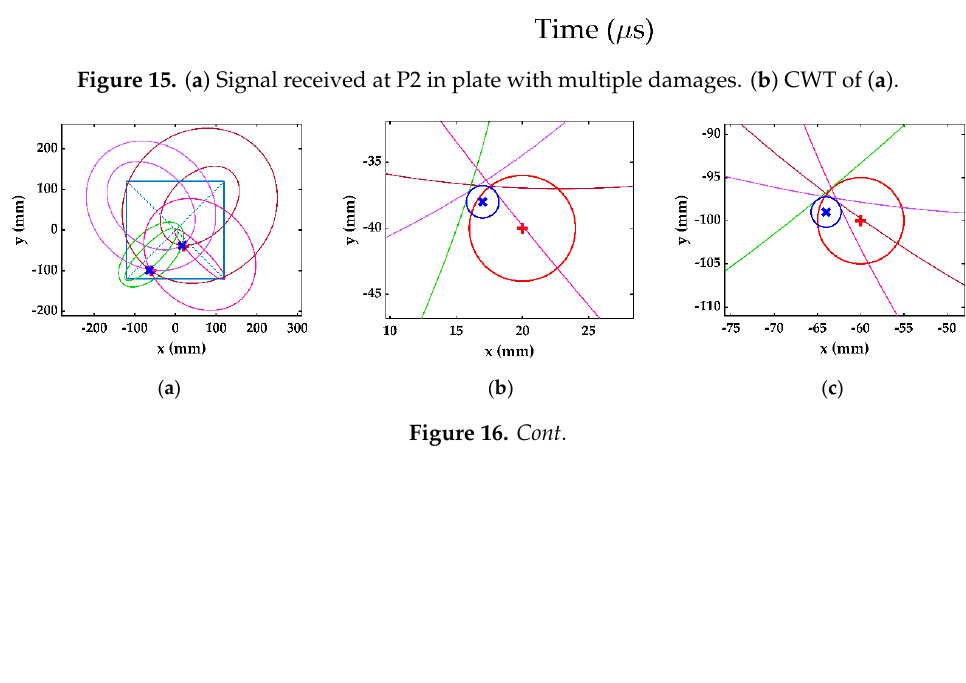
Figure 15. ( a ) Signal received at P2 in plate with multiple damages. ( b ) CWT of ( a ).